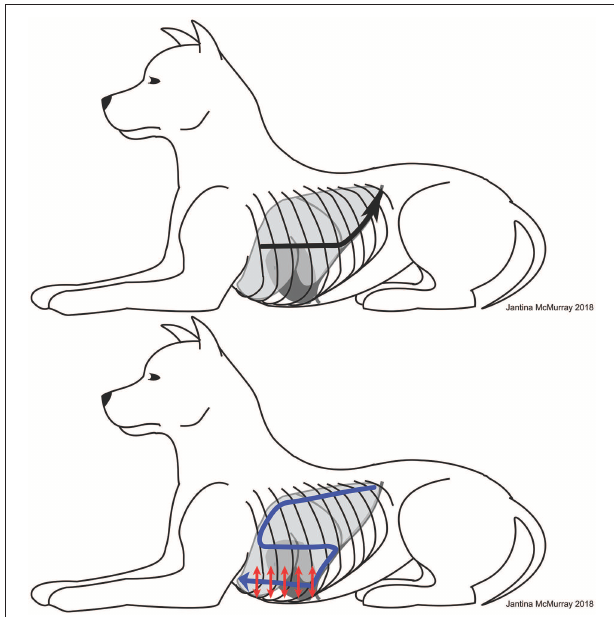
FIGURE 4 | Illustration of the modified Armenise lung ultrasound protocol. Upper image: the ultrasound probe is first placed perpendicular to the ribs, ∼ 1/2 to 2/3 of the way up the thorax, just caudal to the scapula in the 6th intercostal space (widest part of the thorax). The black arrow indicates initial probe positioning followed by sliding of the probe caudally (until the curtain sign is identified), followed by sliding of the probe dorsally along the curtain sign until the hypaxial muscles are identified (loss of the pleural line). The probe is then slowly slid ventrally off the hypaxial muscles until the pleural line reappears (the most caudal dorsal region of the thorax). Lower image: after identifying the most caudal dorsal location, the remainder of the lung and pleural space is evaluated in a similar fashion as described by Armenise et al. ( 3) and follows an S-shaped pattern (blue arrow), with the exception that the curtain sign is identified again in the mid thorax and followed ventrally until it contacts the heart, at which point the probe is turned parallel to the ribs to evaluate the most ventral regions of the thorax for the presence of pleural effusion. The probe can be slid both ventrally and dorsally within each intercostal space with the probe remaining parallel to the ribs to look for lung pathology as well as pleural effusions in the ventral region of the pleural space (red arrows indicate parallel probe positioning with small ventral and dorsal sliding of the